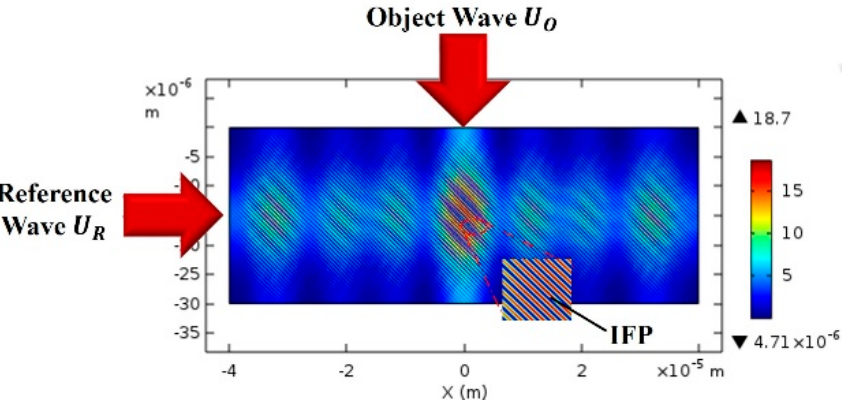
Figure 5. The encryption strength and electric field at 𝜆 (cid:3042) = 𝜆 (cid:3019) = 632.8 nm . (Inset: the interference fringe pattern (IFP) at a 45-degree